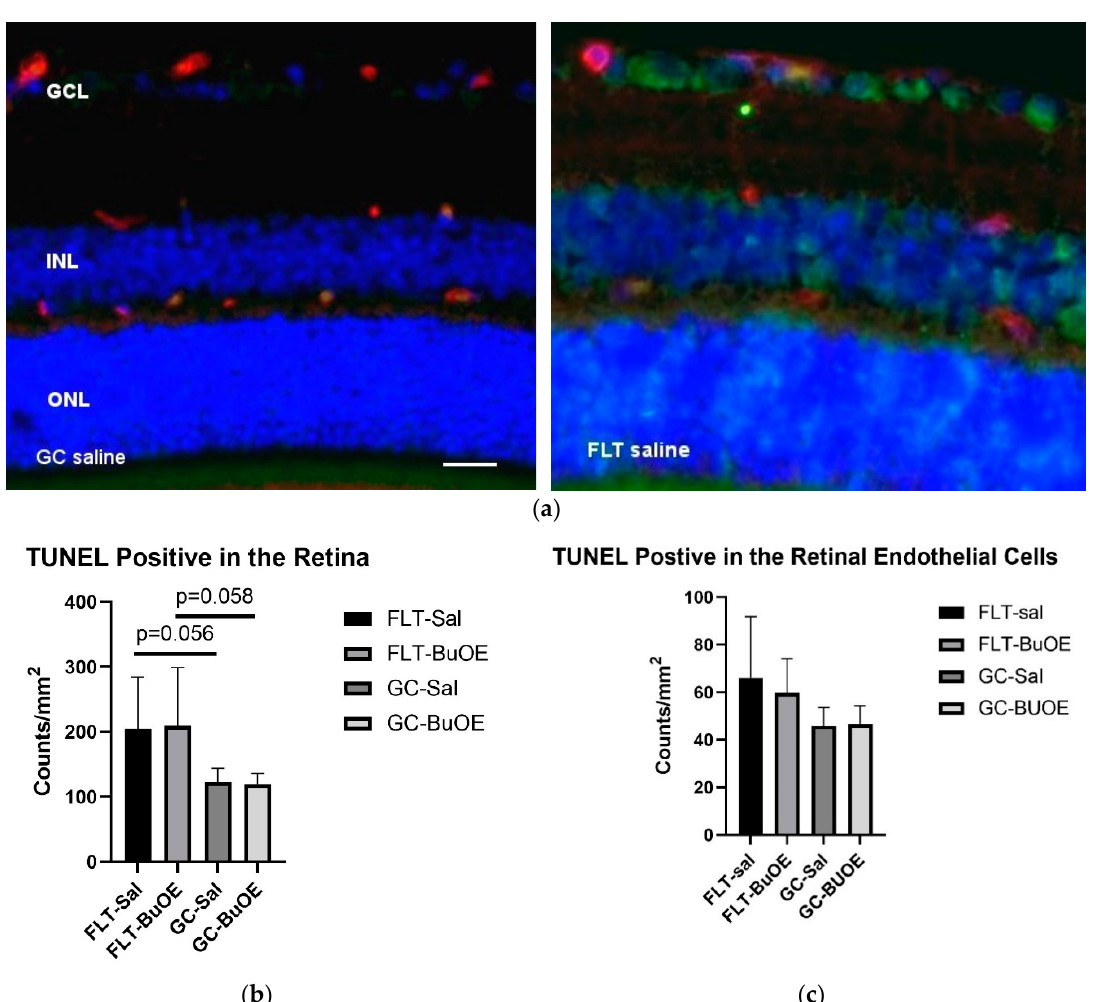
Figure 9. Quanti fi cation of apoptosis based on terminal deoxynucleotidyltransferase dUTP nick-end label (TUNEL) staining of fl ight (FLT) and ground control (GC) mouse retina. ( a ) TUNEL-positive cells were identi fi ed with green fl uorescence and the endothelium was stained with lectin in red. TUNEL-positive cells that were laid within red lectin-labeled endothelium were identi fi ed as TUNEL-positive endothelial cells. The nuclei of photoreceptors were counterstained with DAPI (blue). Scale bar = 50 µm. ( b ) Apoptotic cell density in the retinal outer nuclear layer (ONL), inner nuclear layer (INL), and the ganglion cell layer (GCL) of the FLT and the GC mice. ( c ) Apoptotic cell density in the retinal endothelium of the FLT and GC groups. Values are represented as the mean density ± SEM (n = 5). The density pro fi les were expressed as the mean number of apoptotic-positive cells/mm 2 . Measurements across fi ve retinal sections per eye were used as a single experimental value. Strong trend di ff erences between FLT saline vs. GC saline ( p = 0.058), and FLT BuOE vs. GC BuOE ( p = 0.056).